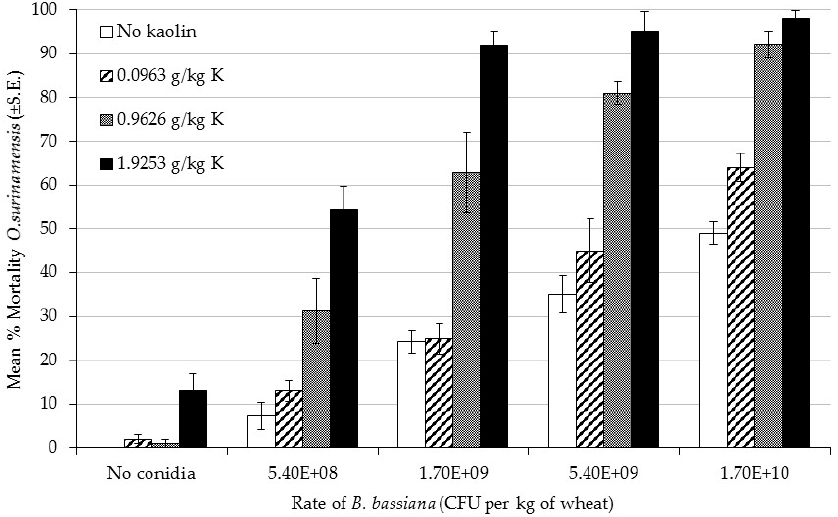
Figure 1. Bioassay 1: Percentage mortality of Oryzaephilus surinamensis adults exposed to Beauveria bassiana IMI389521 at 1 × 10 10 conidia per kg of wheat, kaolin at 1.74 g per kg of wheat, and